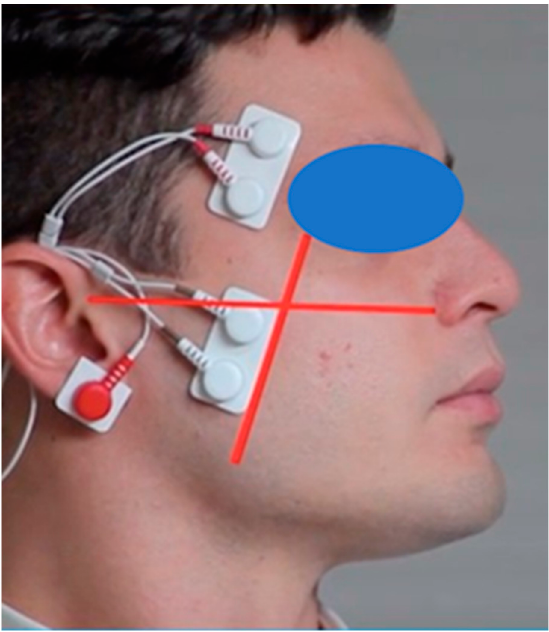
Figure 1. Masseter and temporalis anterior muscles’ electrode placement.